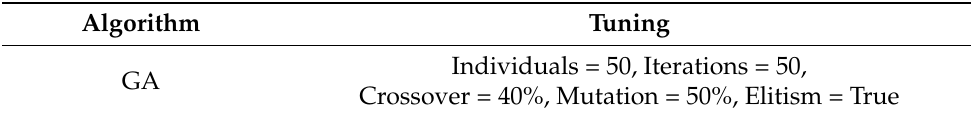
Table 2. The tuning of the algorithm in the